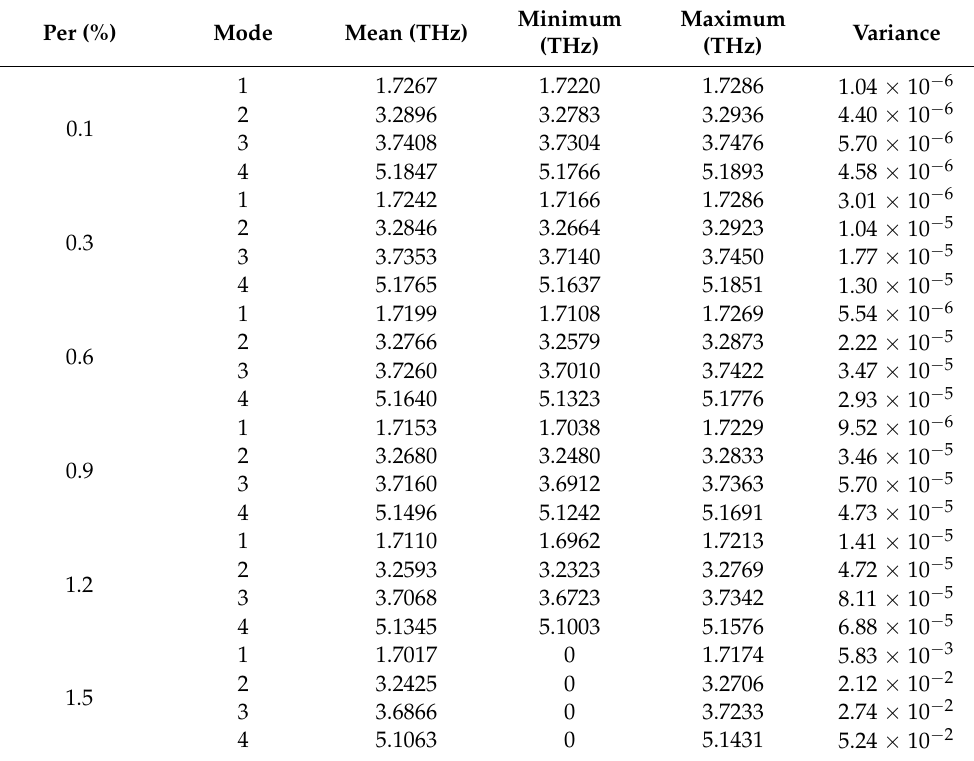
Table 2. Statistical results of resonant frequencies for porous graphene with bond vacancy defects.